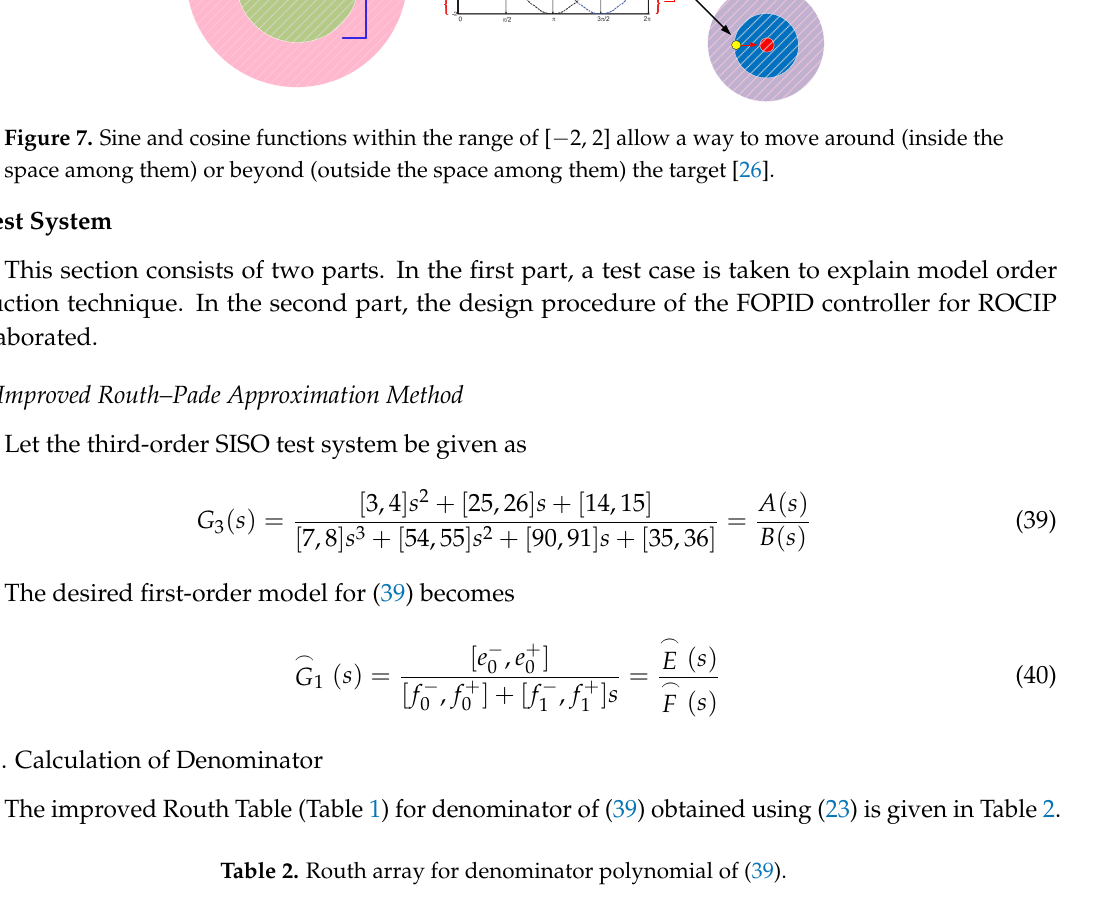
2, 2] allow a way to move around (inside the −